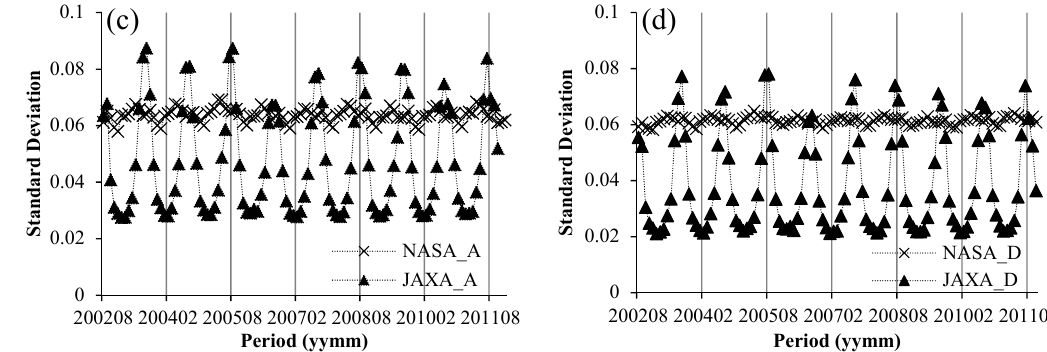
Figure 5. The monthly mean SM and standard deviation of AMSR-E / NASA and AMSR-E / JAXA retrievals for the same 2000 pixels for the Tibetan Plateau from 2002 to 2011: ( a ) SM retrieved with data collected during ascending orbits and ( b ) descending orbits; ( c ) SM standard deviation for ascending orbits, and ( d ) descending orbits.